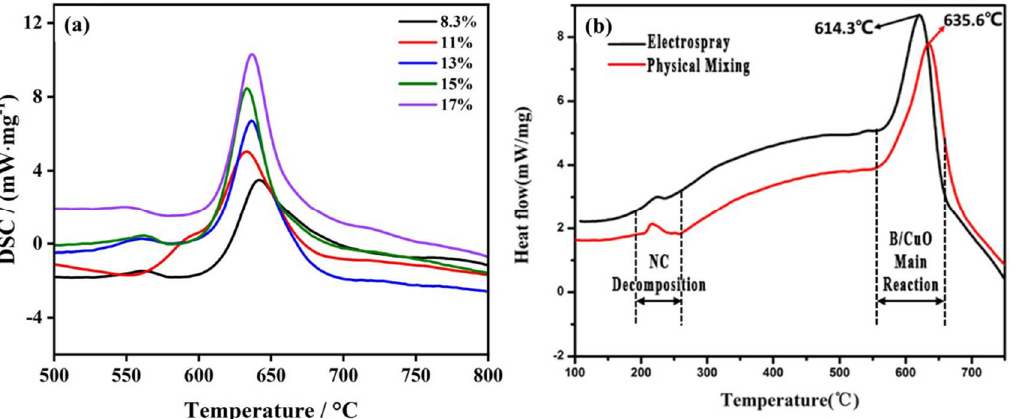
Figure 8. ( a ) DSC curves of different B content of ball-milled B/NC/CuO thermite; ( b ) DSC curves of B(11%)/NC/CuO thermite. Table 6. The parameters of ball-milled B/NC/CuO thermite.